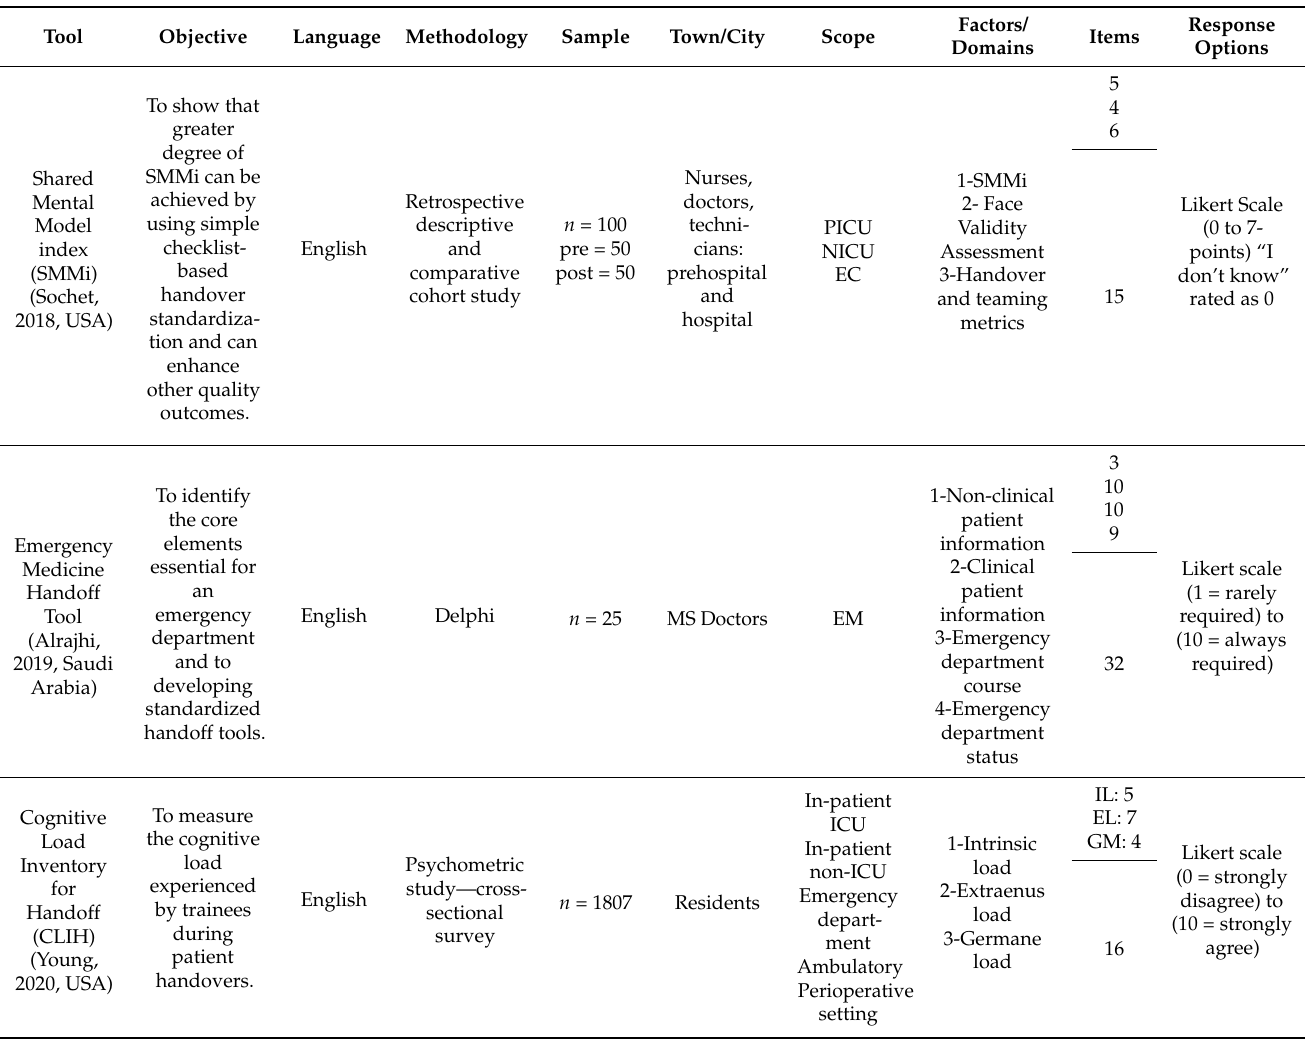
Table 2. General characteristics of the assessment tools.